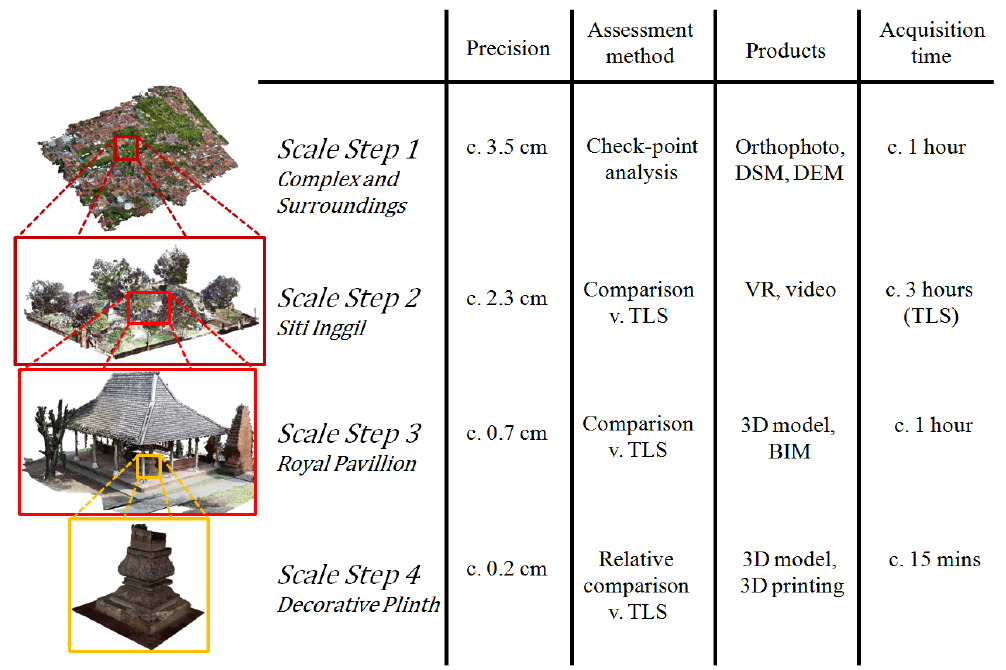
Figure 5. Example of the result of the multi-scale approach. In Step 1, the whole Kasepuhan complex and its surroundings are modeled by aerial photogrammetry. Step 2 shows the Siti Inggil area within the palace compounds; here is shown the registered TLS point cloud. Step 3 shows a building, the Royal Pavilion, within Siti Inggil, which was modeled using close-range photogrammetry. Finally, Step 4 shows an architectural detail, in this case a column’s plinth, also modeled using close-range